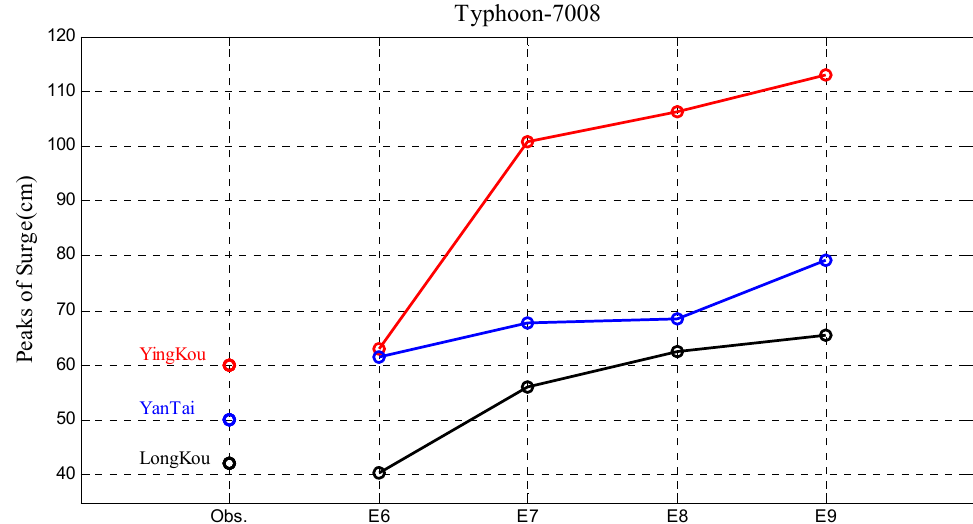
Figure 11. Storm surge elevations in four experiments (E6–E9), observations (black line) ( top ), and their differences ( bottom ) during Typhoon 7008 at YanTai station.